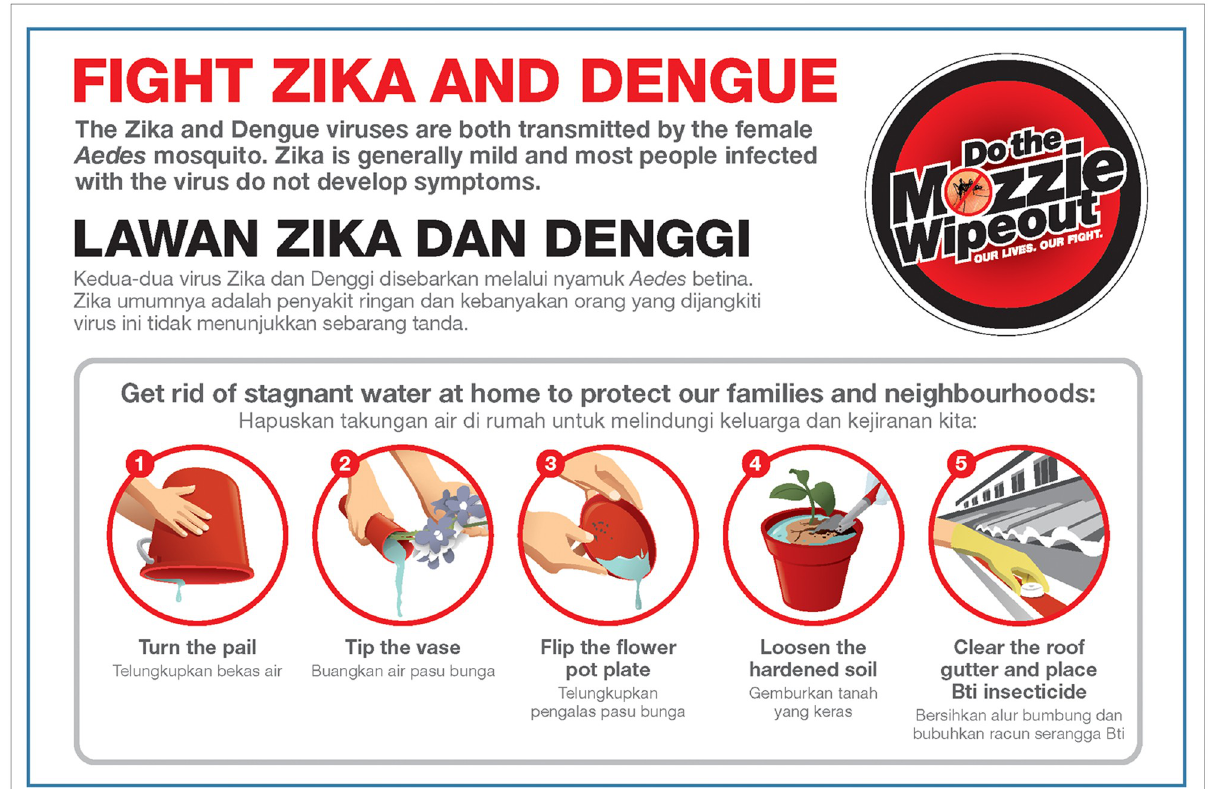
Fig 6. ‘5-Step Mozzie Wipeout’ behaviour change communication